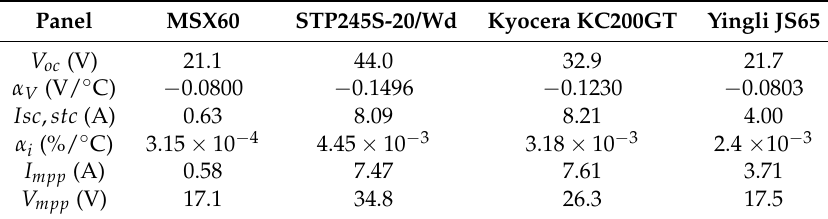
Figure 15. Model of the irradiation system in simulink @ . Table 2. Technical data of the PV panel.